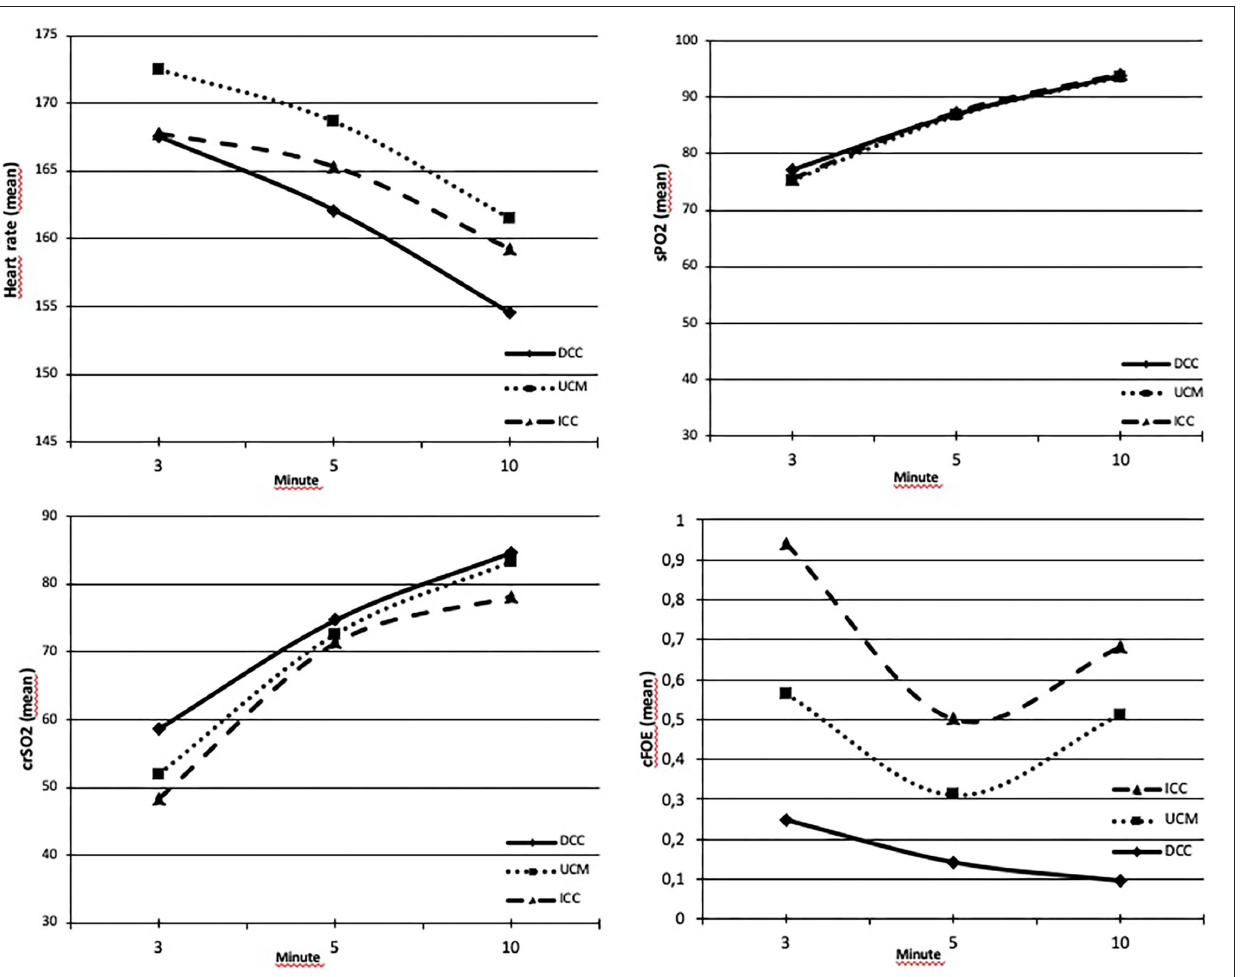
FIGURE 3 | (A) Heart rates (HRs) were similar between groups at the 3rd, 5th, and 10th min ( p > 0.05). (B) SpO2 values were similar between groups at the 3rd, 5th, and 10th min ( p > 0.05). (C) crSO 2 values were higher at the 3rd and 10th min in the DCC group ( p = 0.042 and p = 0.045, respectively) and similar in all groups within normal range at the 5th min ( p = 0.61). (D) cFOE values were the highest at the 3rd and 10th min in the ICC group ( p = 0.011 and p < 0.001,